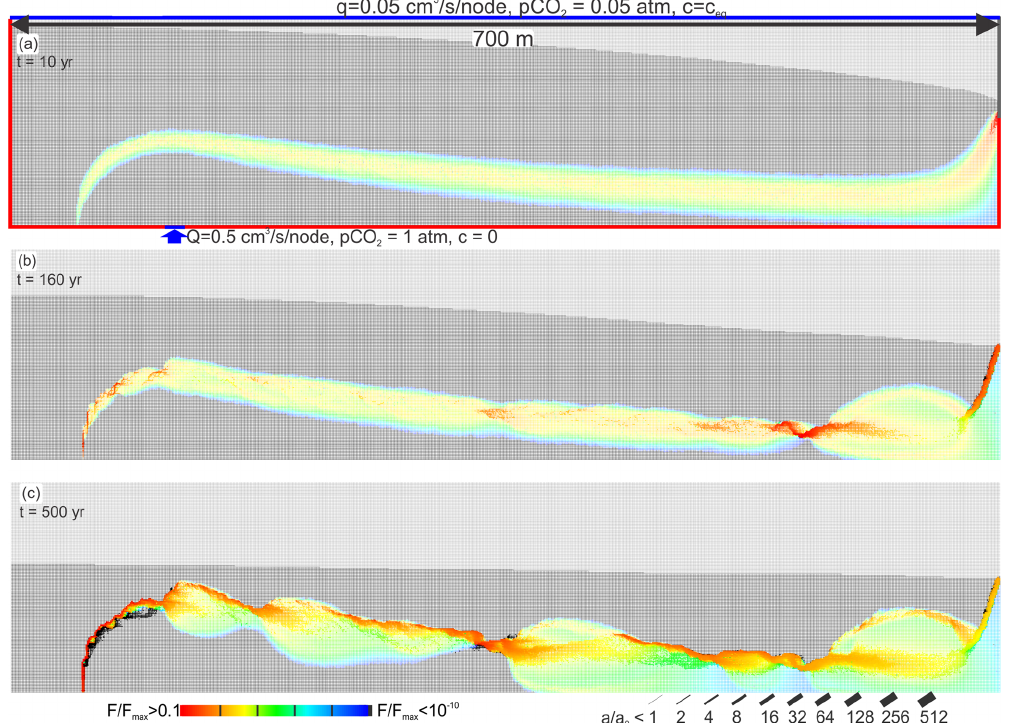
Figure 17. Standard scenario with horizontal extension of the modelling domain from 500 to 1400m. Several constrictions occur downstream.